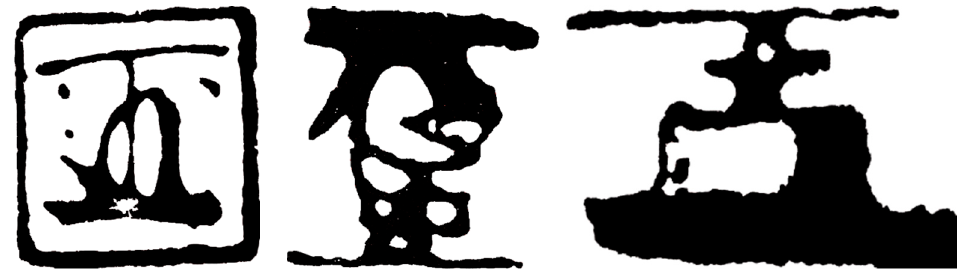
Figure 33. The Song Yuan Huaya carved with an ethnic character. The period of the Song and Yuan Dynasties. Sketched by author. Picture source: Shi (1995), pp. 68, 69. According to Qizong Jin’s Jurchen dictionary and other Jurchen study resources, the character